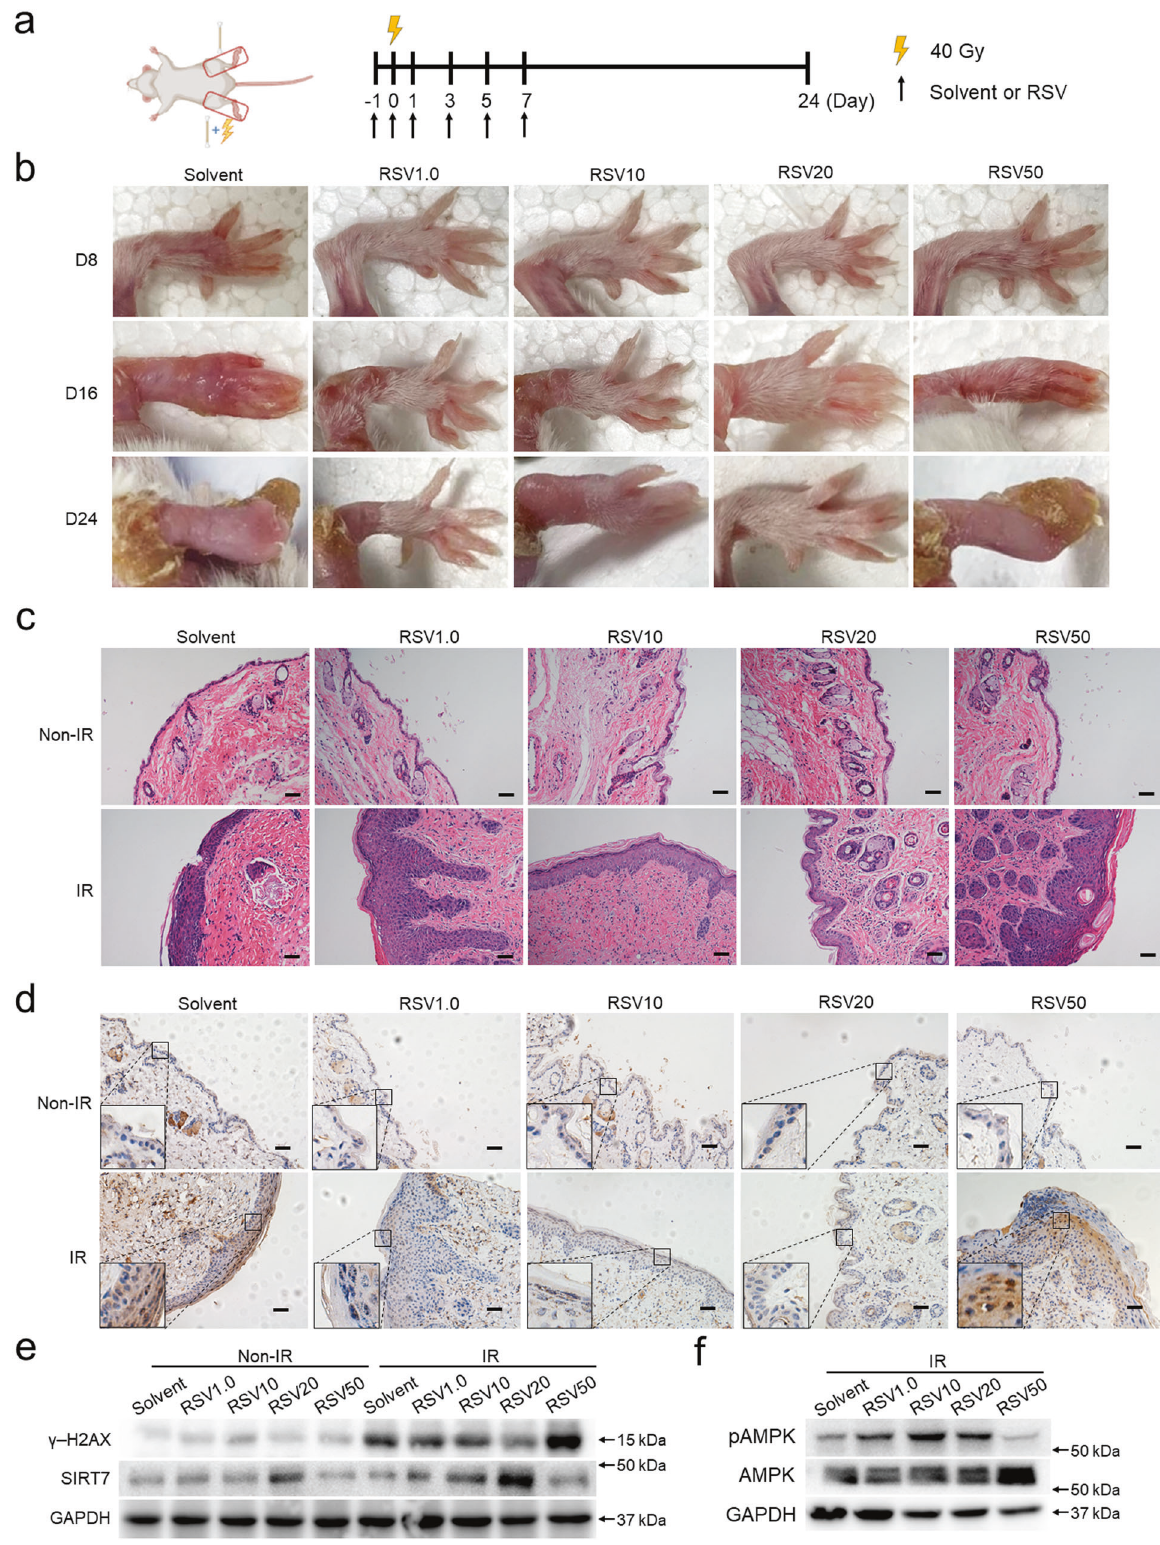
Fig. 6 RSV alleviates radiation-induced skin injury in vivo. a Schematic illustration showing the time course to establish mice CRI model. b Representative CRI images of posterior limbs from 40 Gy X-ray-treated mice on day 8, 16, and 24. c Histological analysis of the cutaneous tissues from control and 40 Gy X-ray-treated mice. d IHC detection of γ -H2AX of the cutaneous tissues from control and 40 Gy X-ray-treated mice. Scale bar: 50 μ m. γ -H2AX and SIRT7 ( e ) and pAMPK ( f ) were detected by Western blot in the cutaneous tissues from the cutaneous tissues from control and 40 Gy X-ray-treated